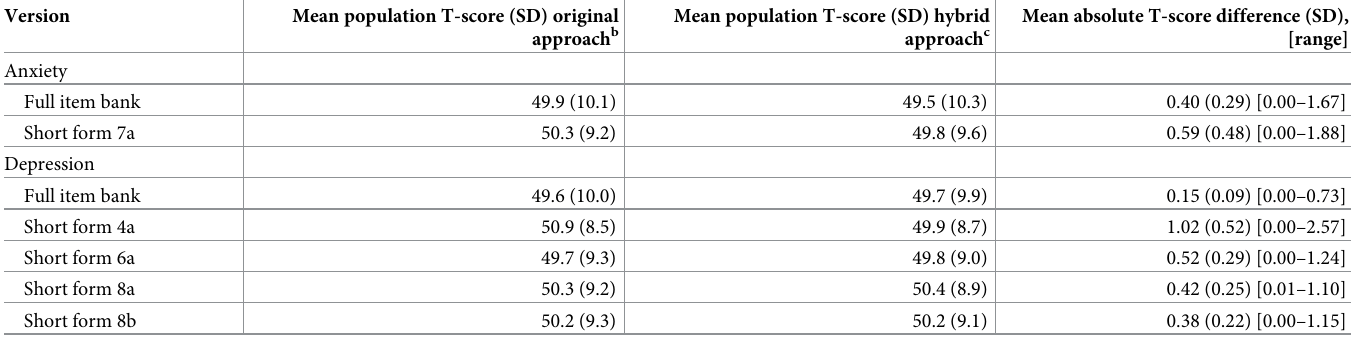
Table 3. PROMIS anxiety and depression T-scores a based on different sets of item parameters for different versions of the instruments.